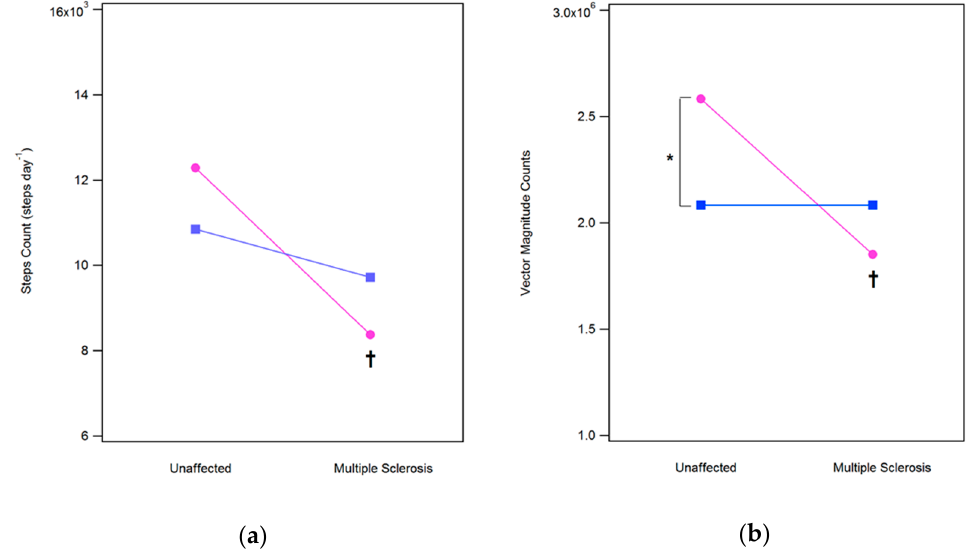
Figure 1. Comparison of Daily Steps ( a ) and Vector Magnitude Counts ( b ) for women (pink line) and men (blue line) with Multiple Sclerosis and unaffected individuals. The symbol † denotes a significant difference between unaffected individuals and people with MS after Bonferroni correction ( p < 0.025). The symbol * denotes a significant difference between women and men after Bonferroni correction ( p < 0.025).